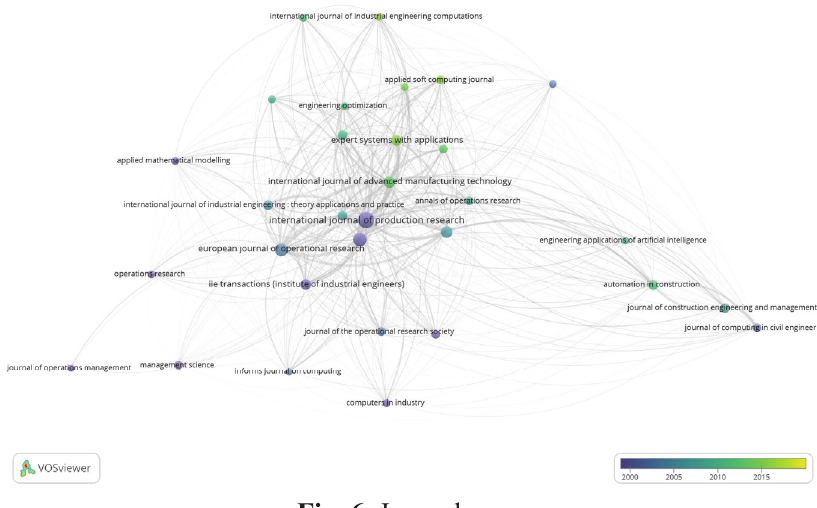
Fig. 6. Journals map